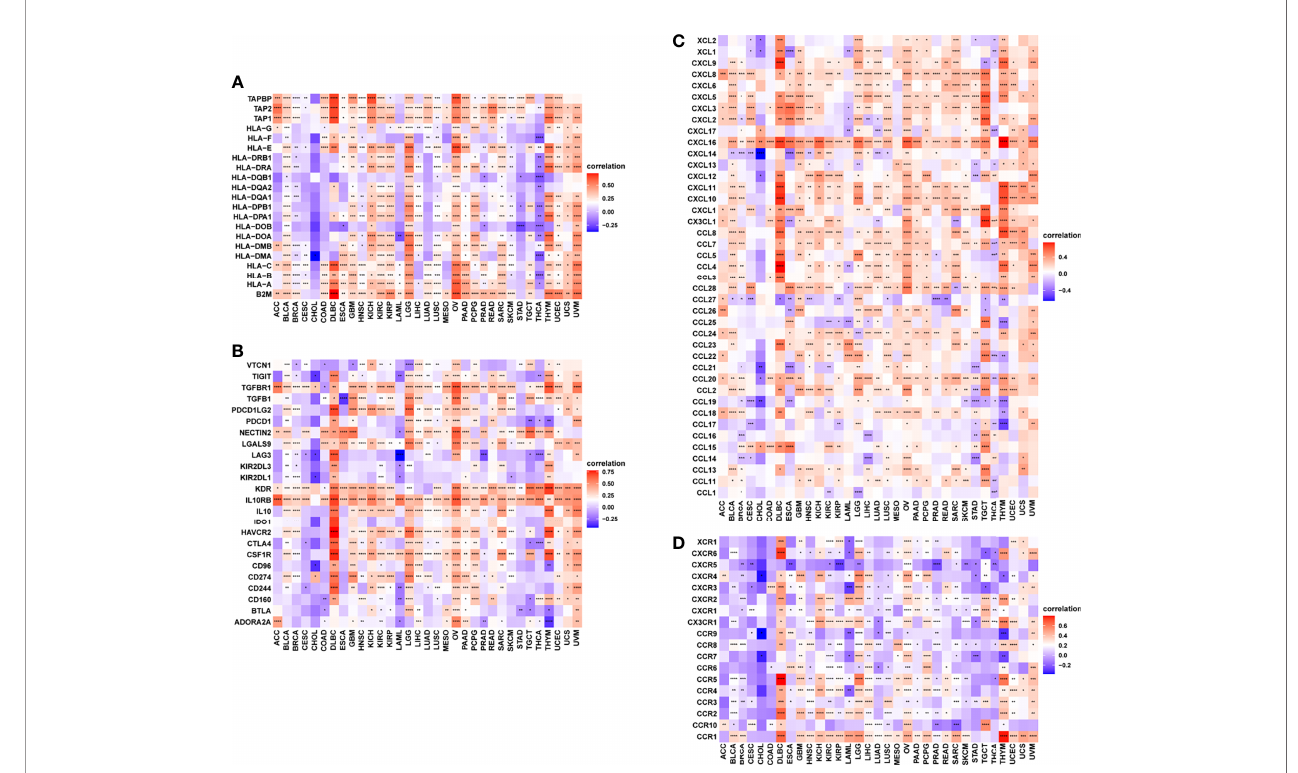
FIGURE 8 | Relationship between FUCA2 expression and that of immune-related genes. (A) MHC genes. (B) Immunosuppressive genes. (C) Chemokines (D) . Chemokine receptors. Red represents positive correlation, blue represents negative correlation, and the darker the color, the stronger the correlation. *P < 0.05, **P < 0.01, ***P < 0.001, ****P <